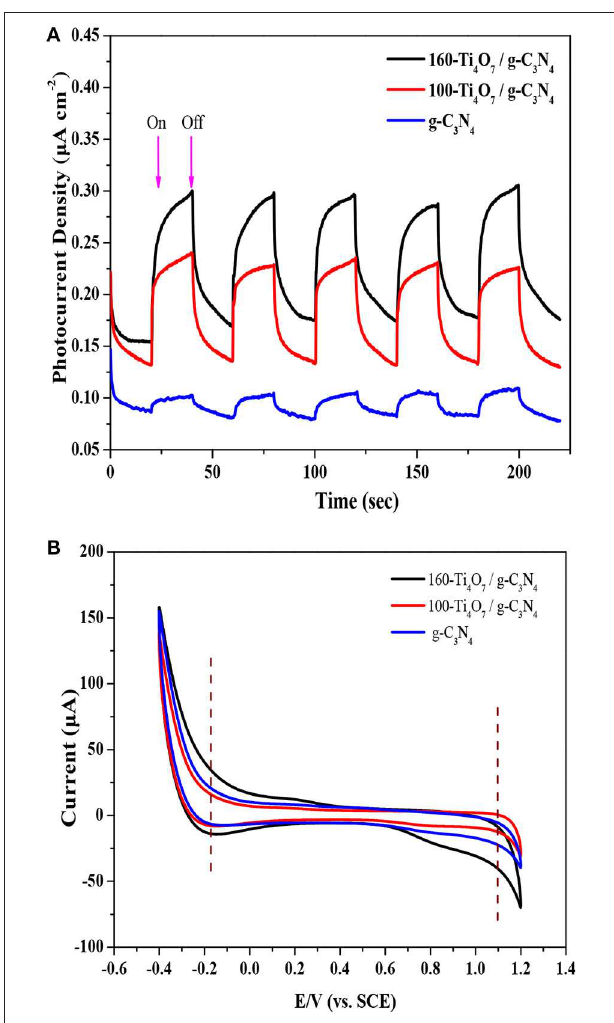
FIGURE 5 | Electrochemical properties analysis of the 160-Ti 4 O 7 /g-C 3 N 4 photocatalyst. (A) photocurrent density of different photocatalysts; (B) cyclic voltammogram scan of different photocatalysts.